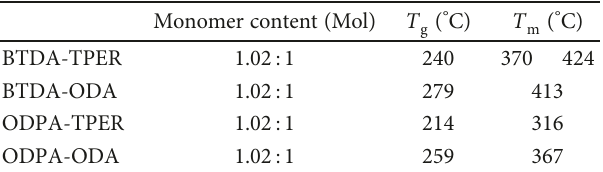
Table 1: Thermal properties of synthesized polyimides.